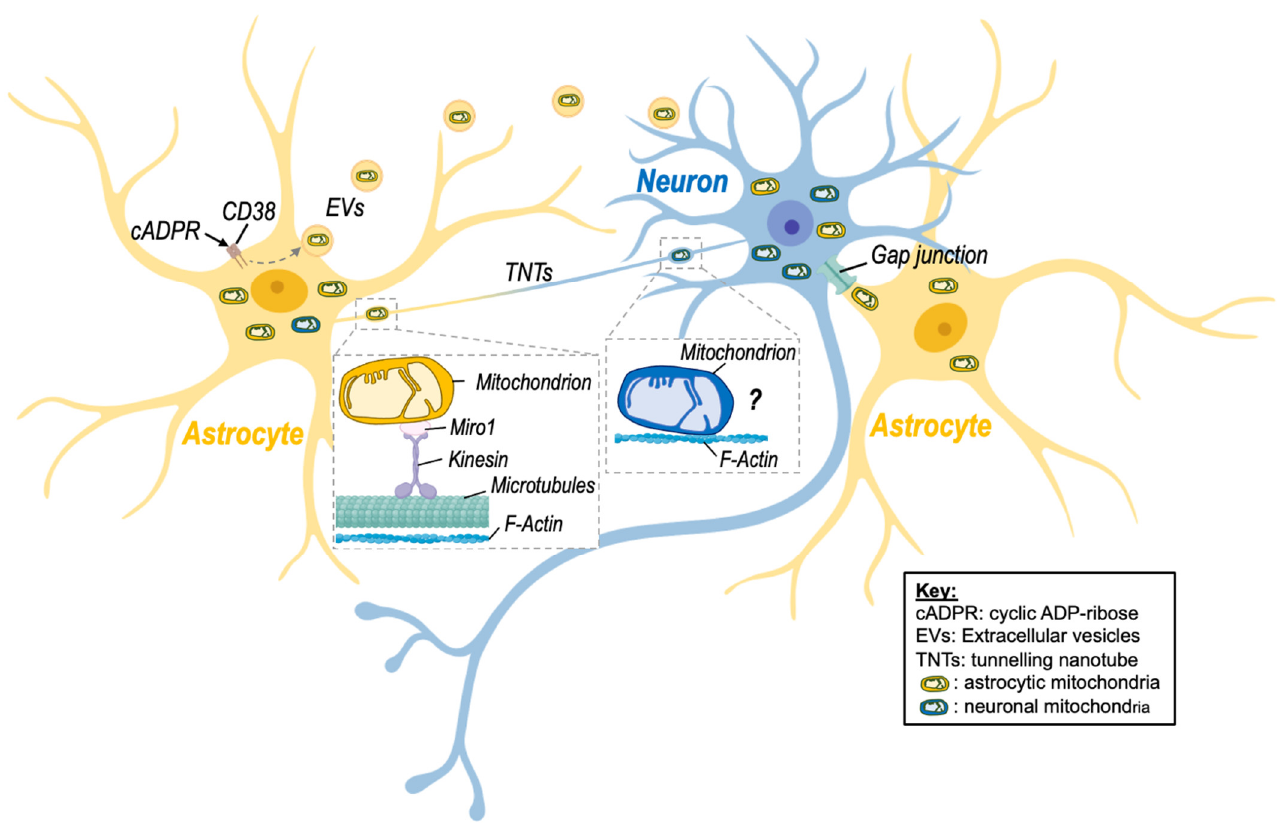
Figure 1. Intercellular mitochondrial transfer between neurons and astrocytes. Evidence of mito- chondrial transfer between neurons and astrocytes has been described, and different processes have been highlighted. Namely, activation of CD38 (cluster of differentiation 38) by cyclic ADP-ribose (cADPR) induced the release of extracellular vesicles (EVs)-containing mitochondria by astrocytes in a model of stroke, improving neuronal viability. Transfer of mitochondria via tunnelling nanotubes (TNTs) has also been shown. This mode of transfer seems to rely on components of the cytoskeleton (microtubules and F-actin) as well as on the mitochondrial Rho-GTPase-1 protein (Miro-1) and its connection with kinesin for mitochondrial transport. Although transfer of neuronal mitochondria via TNTs is depicted on the figure, there is no clear evidence that mitochondria can be transferred from neurons to astrocytes via this route. Transfer of mitochondria between neuronal cells might involve microtubule-independent mechanism that remain to be identified. Nevertheless, transfer of astrocytic mitochondria to neurons via TNTs has been described. Other processes involv- ing gap junctions may also be involved but still need to be studied in more detail in the brain. Cre- ated with BioRender.com (accessed on 7 November 2022).